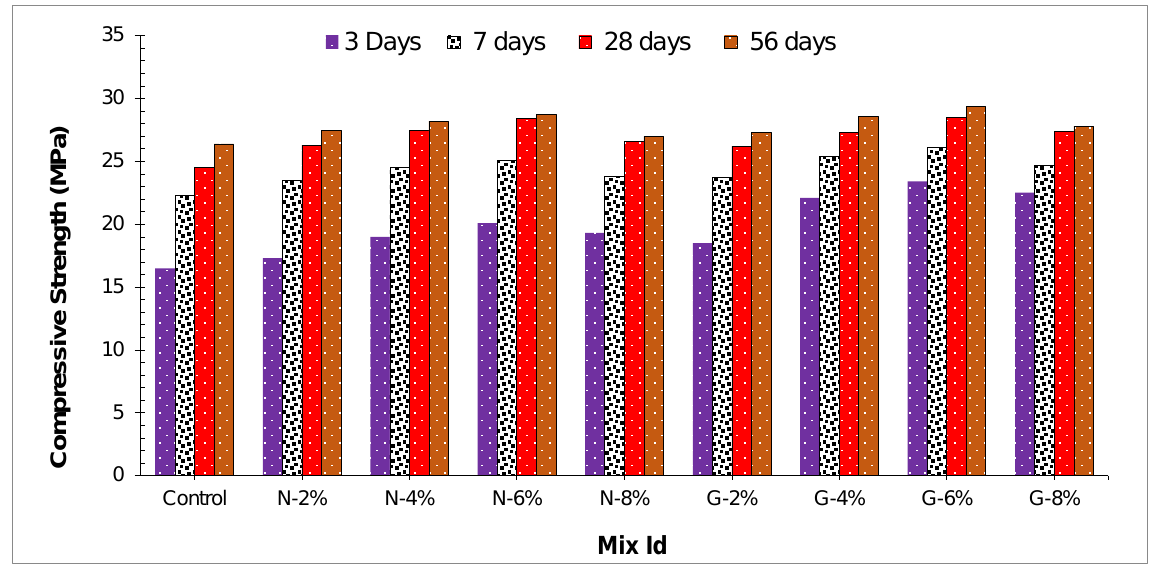
Figure 5. Compressive strength of concrete.